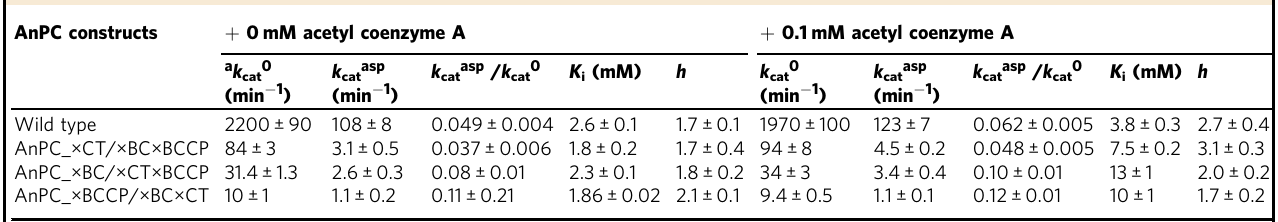
Table 5 Inhibition of wild-type AnPC and AnPC hybrid tetramers by L -aspartate in the presence and absence of